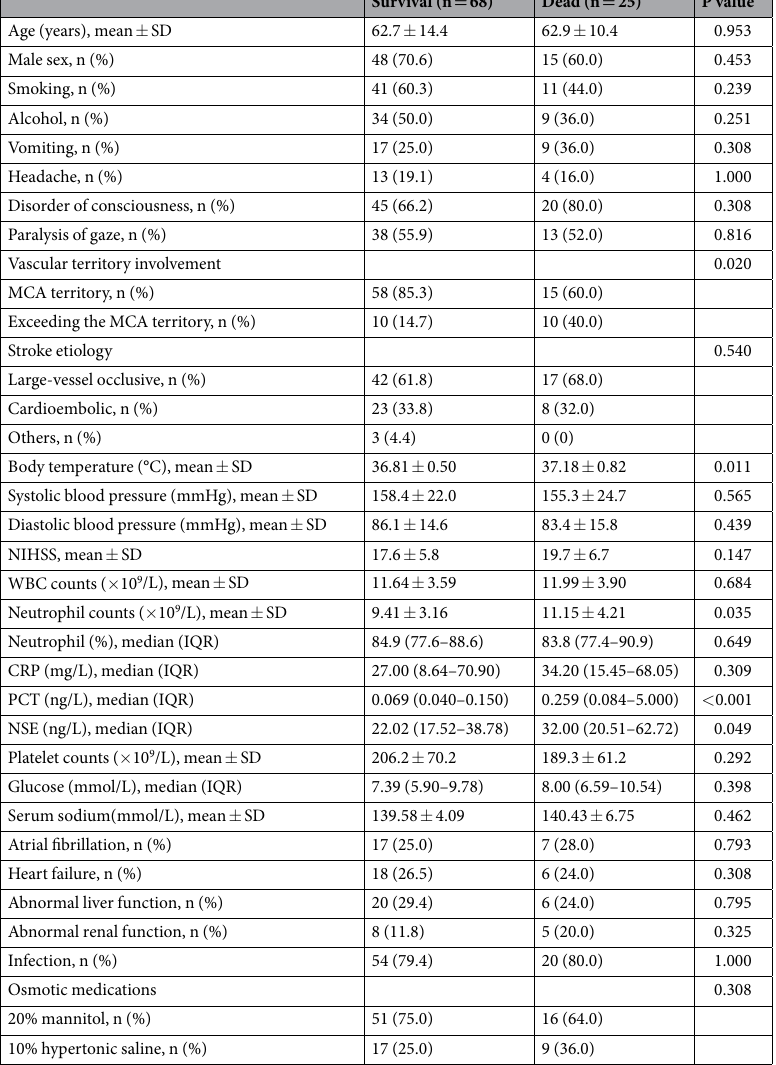
Table 1. Demographic and clinical differences between dead and surviving patients with